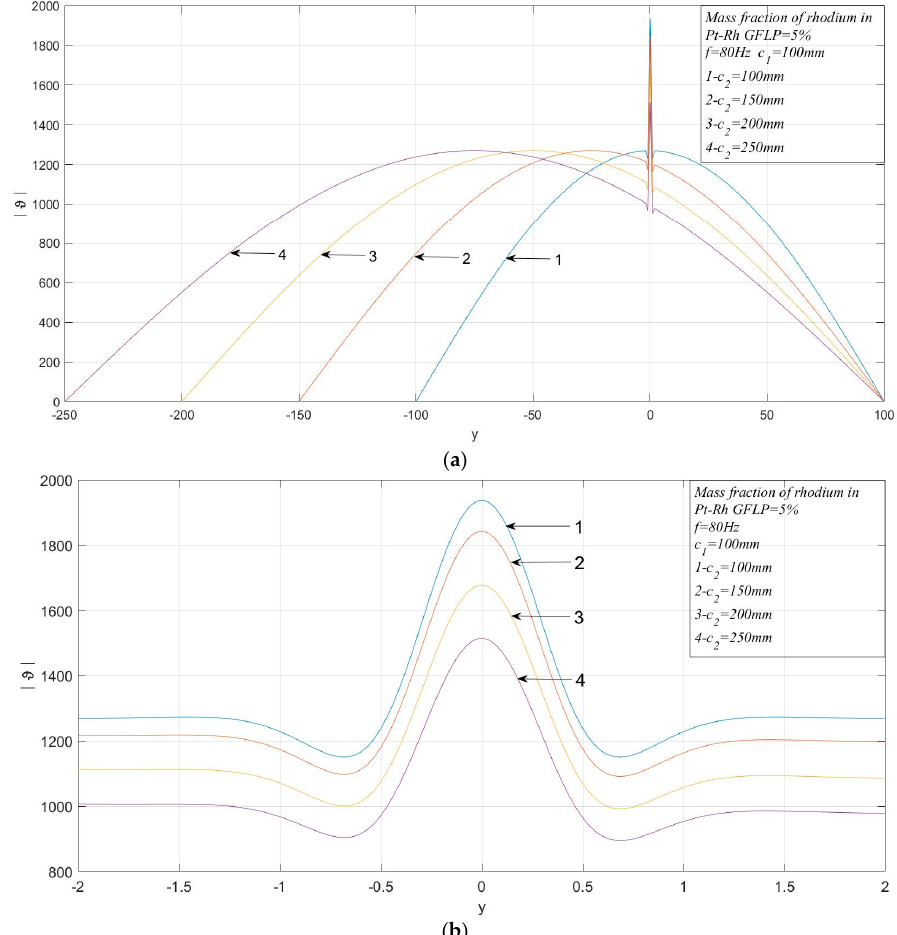
Figure 4. ( a ) Temperature near the circular opening of Pt–Rh GFLP ( b ) . Temperature near the circular opening of Pt–Rh GFLP. opening of Pt–Rh